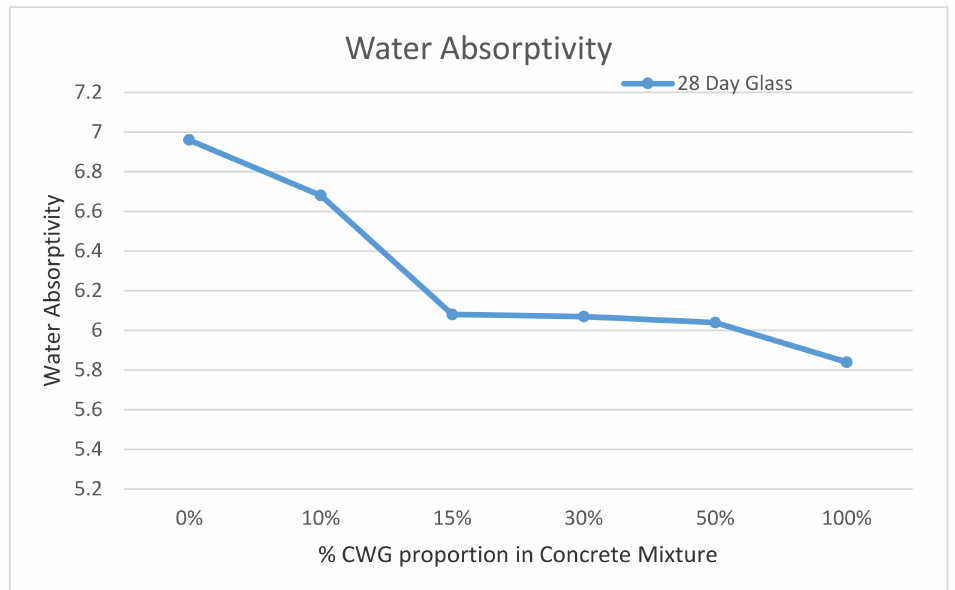
Figure 11. Effect of the density of concrete